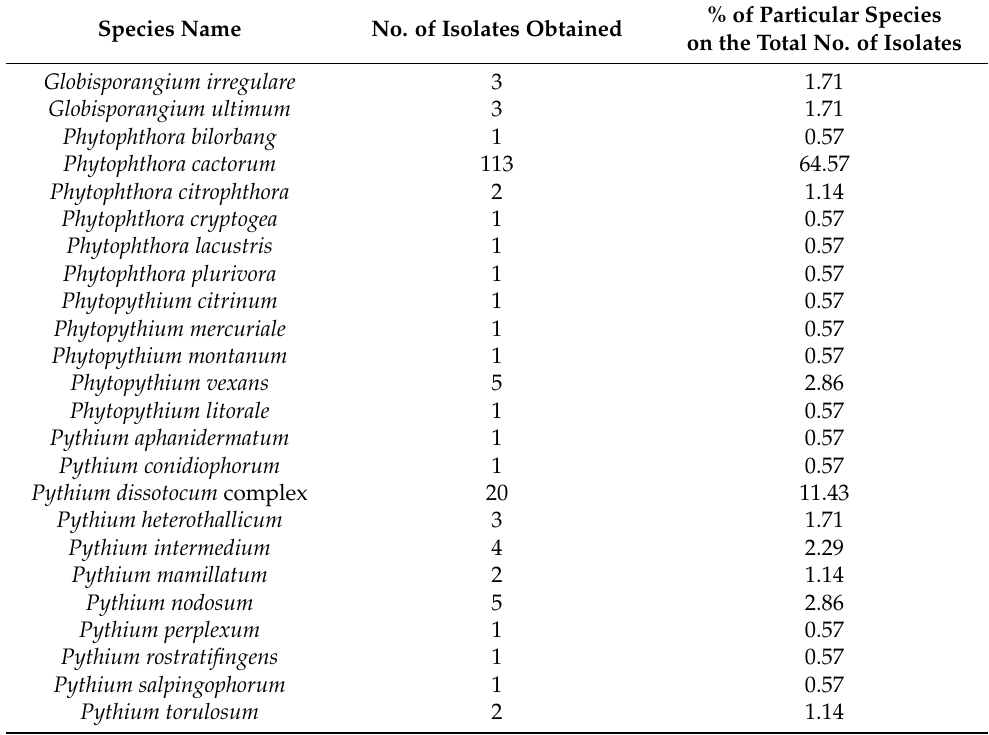
Table 1. List of the species of the order Peronosporales isolated in strawberry fields in the Czech Republic.